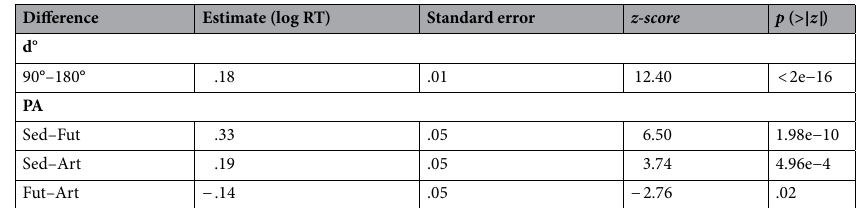
Table 2. Influence of d° (degrees of the rotation, i.e.: 90° or 180°) and PA (physical activity with three PA groups: sedentary subjects, Sed, artistic gymnasts, Art and futsal players, Fut) on the MR task performance (measured as log RT). Multiple comparisons were carried out using the method of Bretz, Hothorn and Westfall 40 (family-wise error rate set at 5%). The marginal means of the interaction effect between d° and PA on the log RT were used to compute the suitable contrasts in log RT. The corresponding differences (Estimate) are given as log RT values. Standard-error, z -score and p -value [single-step method; p > | z | ] are also given.